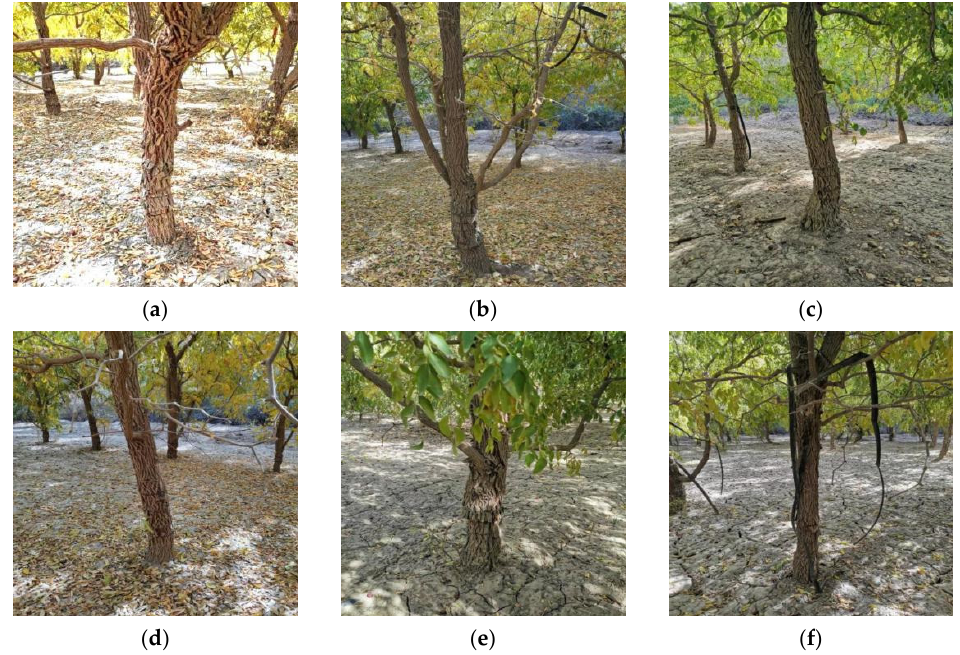
Figure 1. Trunks of red jujubes in different scenes. ( a ) Sunny day, ( b ) Cloudy day, ( c ) Multiple targets, ( d ) Shading by branch, ( e ) Shading by leaves, ( f ) Shading by sundries.